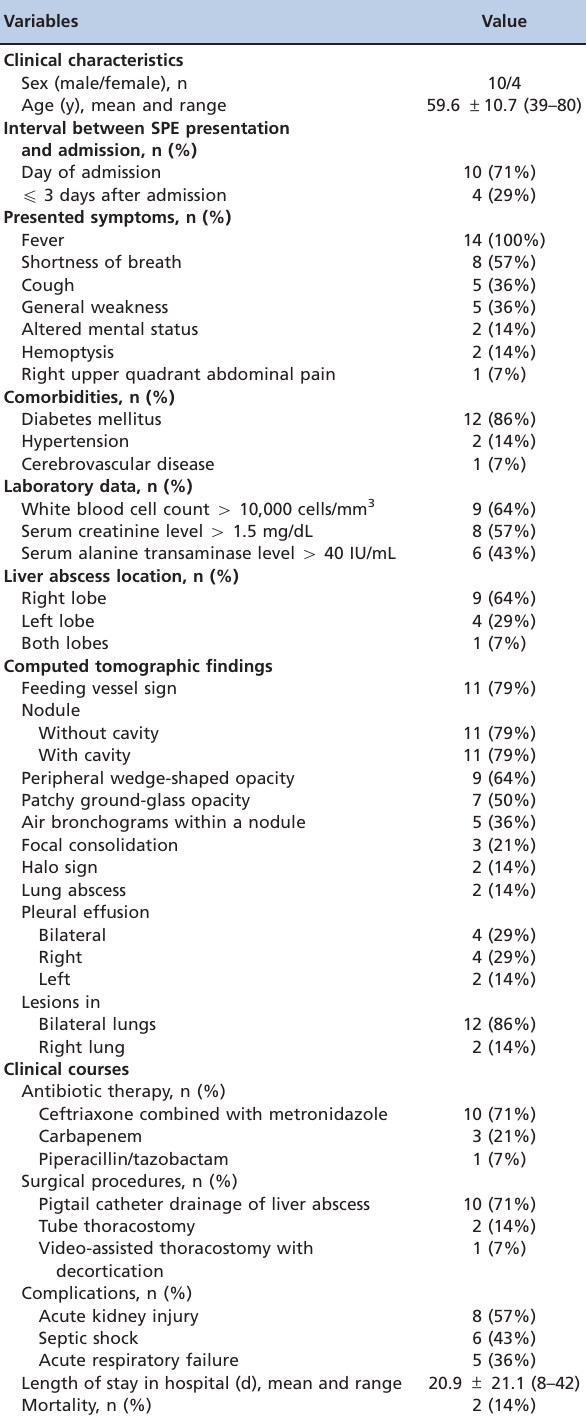
Table 1 - Clinical characteristics, computed tomographic findings, and clinical courses of the 14 patients with septic pulmonary embolism caused by a Klebsiella pneumoniae liver